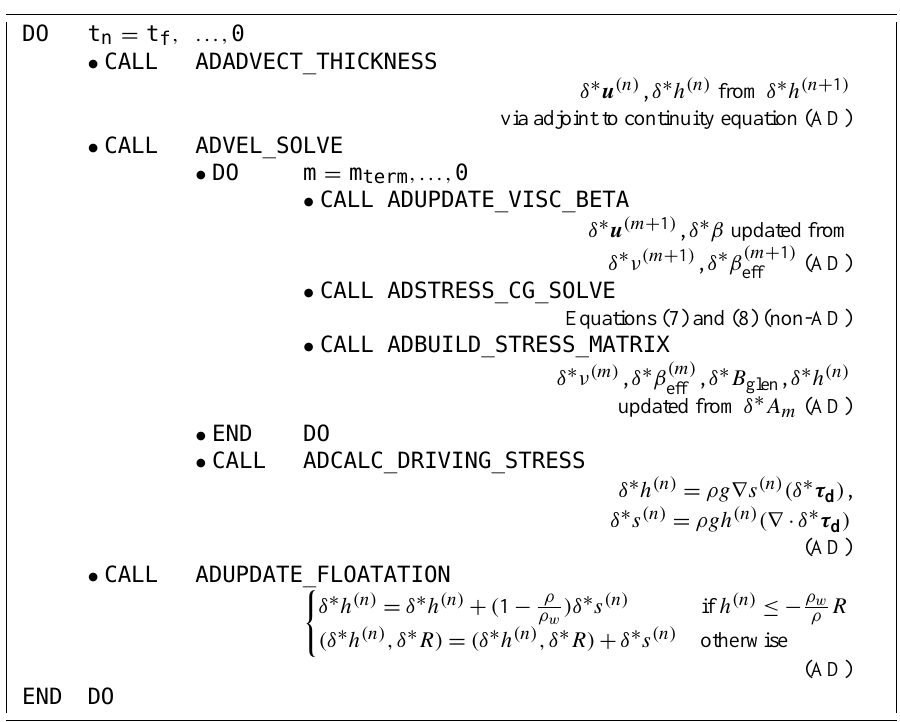
Table 2. Pseudocode version of adjoint model reverse-time-stepping algorithm corresponding to Table 1. (AD) indicates that this step is processed by the algorithmic differentiation